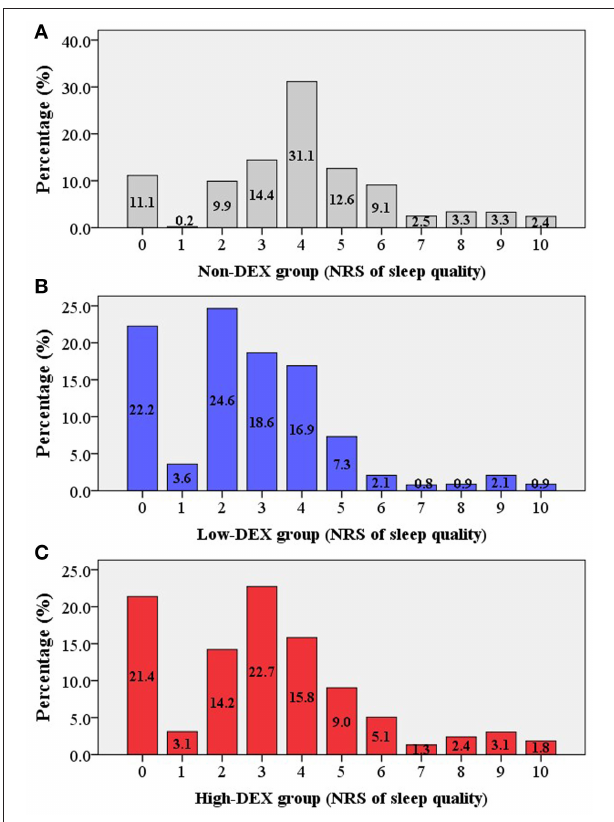
FIGURE 2 | Bar-chart plot of the NRS of sleep quality in the different groups [ (A) Non-DEX group; (B) Low-DEX group; (C) High-DEX group]. Box, percentage.